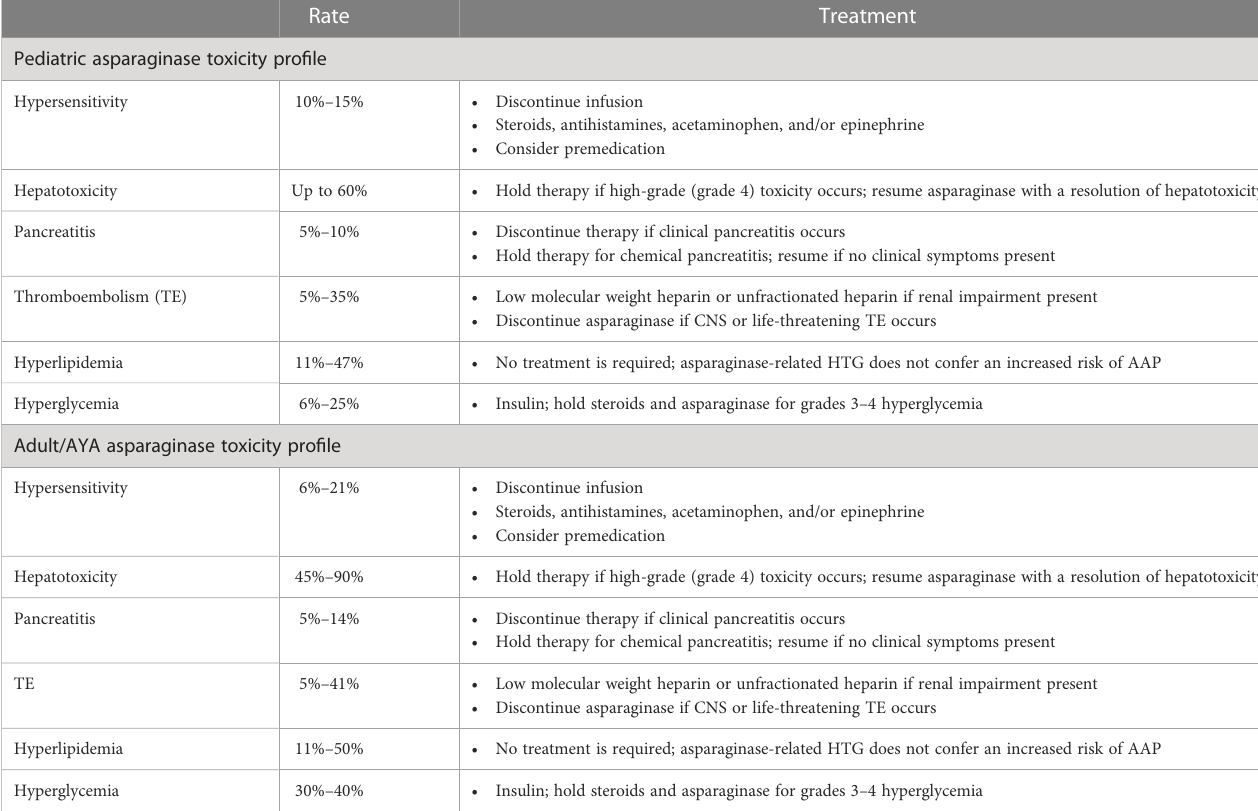
TABLE 2 Comparison of toxicity rates between pediatric and AYA/adult patients receiving asparaginase